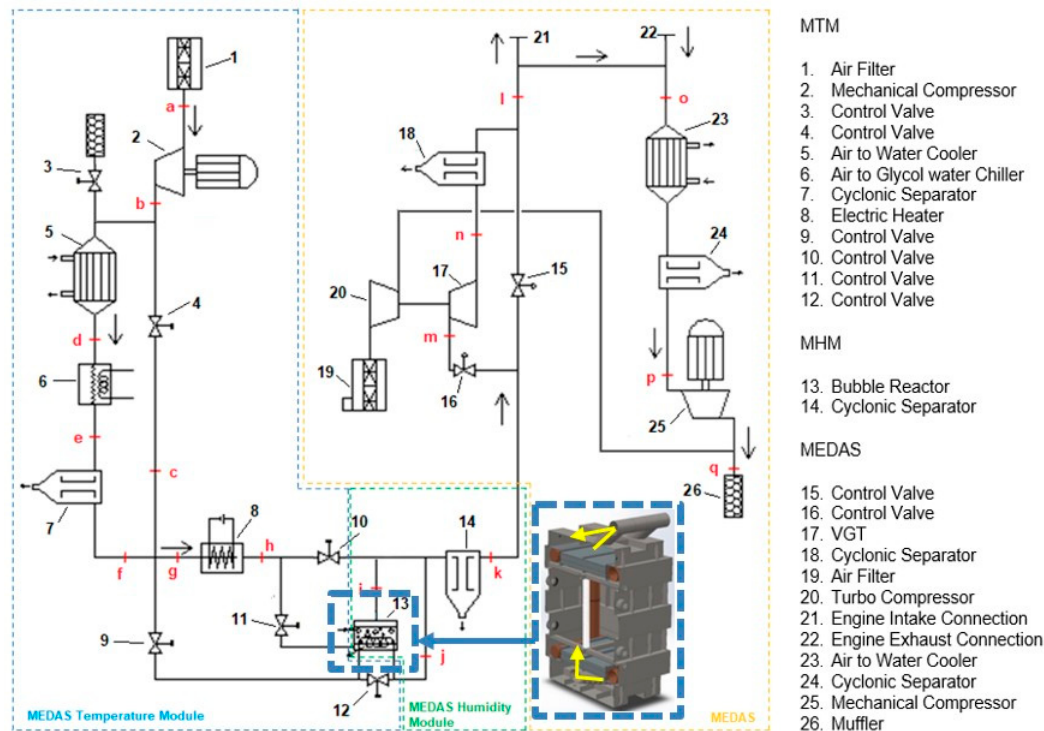
Figure 2. Testing installation scheme.